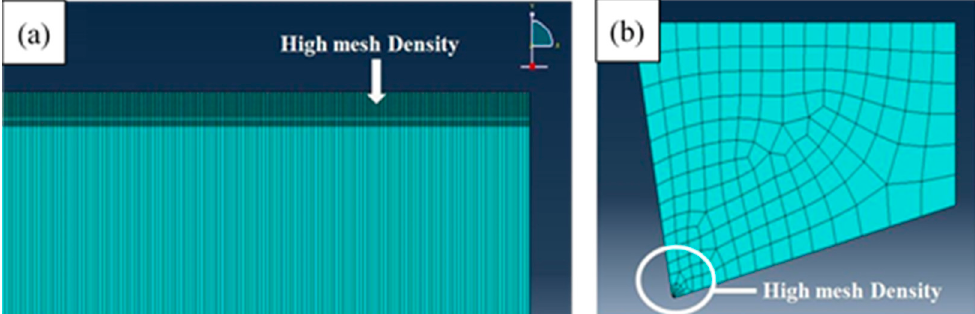
Figure 2. Meshing of ( a ) the workpiece and ( b ) the cutting tool.